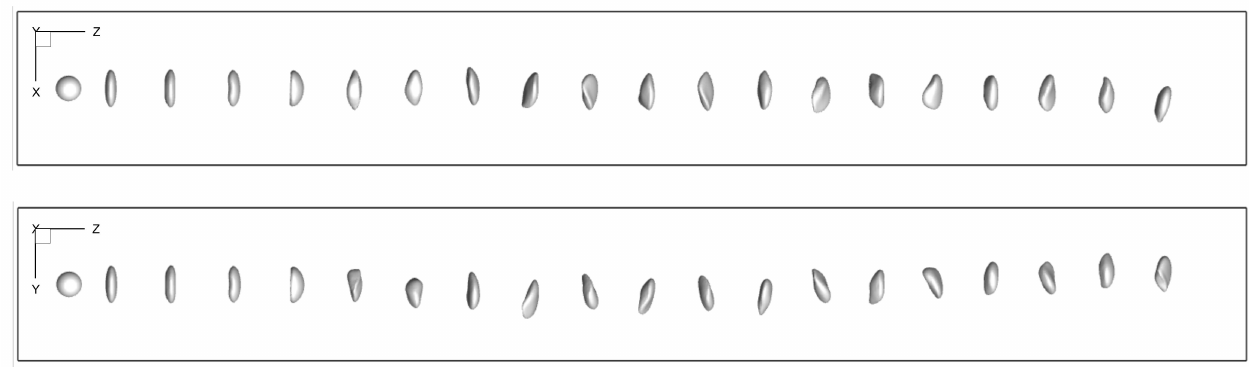
Figure 8. Evolution of bubble shape (drawn horizontally for convenience) for G-B0 with Grid index = 1.00. The bubble shapes are drawn at time intervals of 0.05